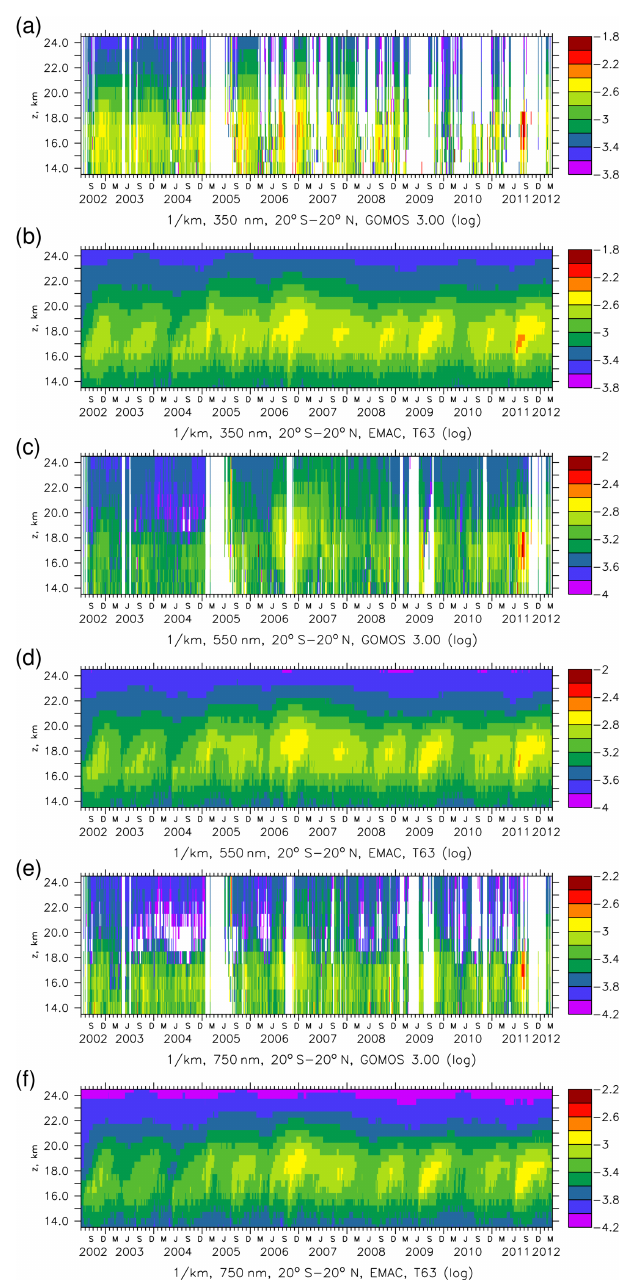
Figure 1. GOMOS and EMAC extinctions (log) in the tropics as a function of altitude for different wavelengths: (a, b) UV 350nm, (c, d) visible 550nm and (e, f) near-infrared 750nm; resolution